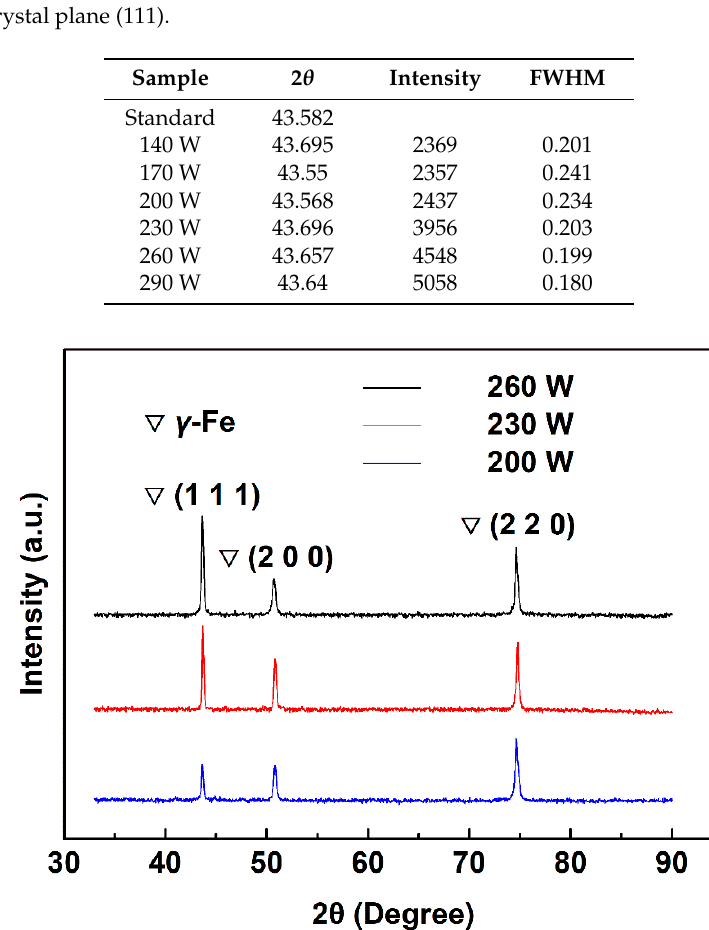
Figure 6. XRD patterns of specimens under different types of laser power.